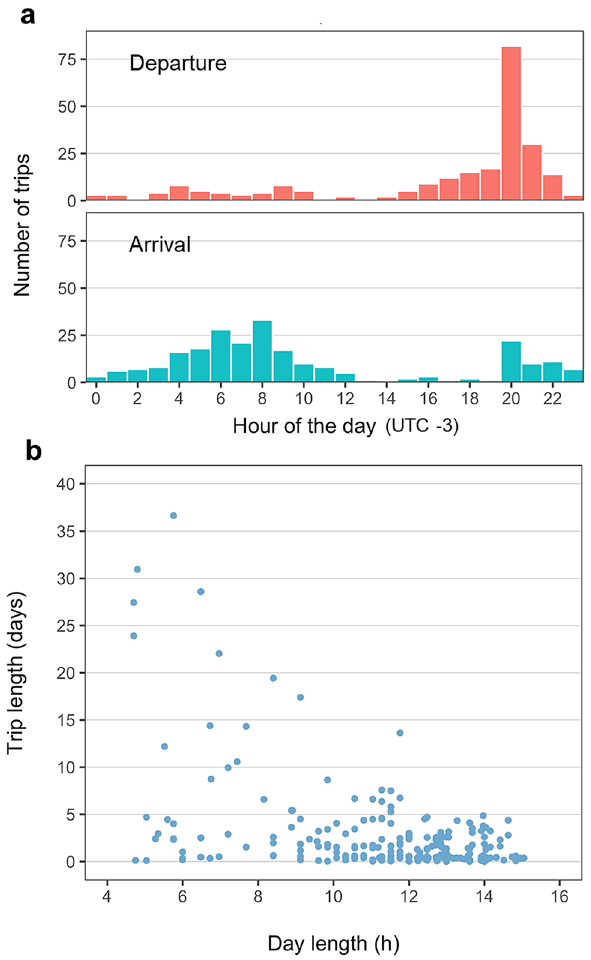
Figure 3. Foraging trips of juvenile and sub-adult male Antarctic fur seals. ( a ) Histogram of departure and arrival times. ( b ) Relationship between day length and trip